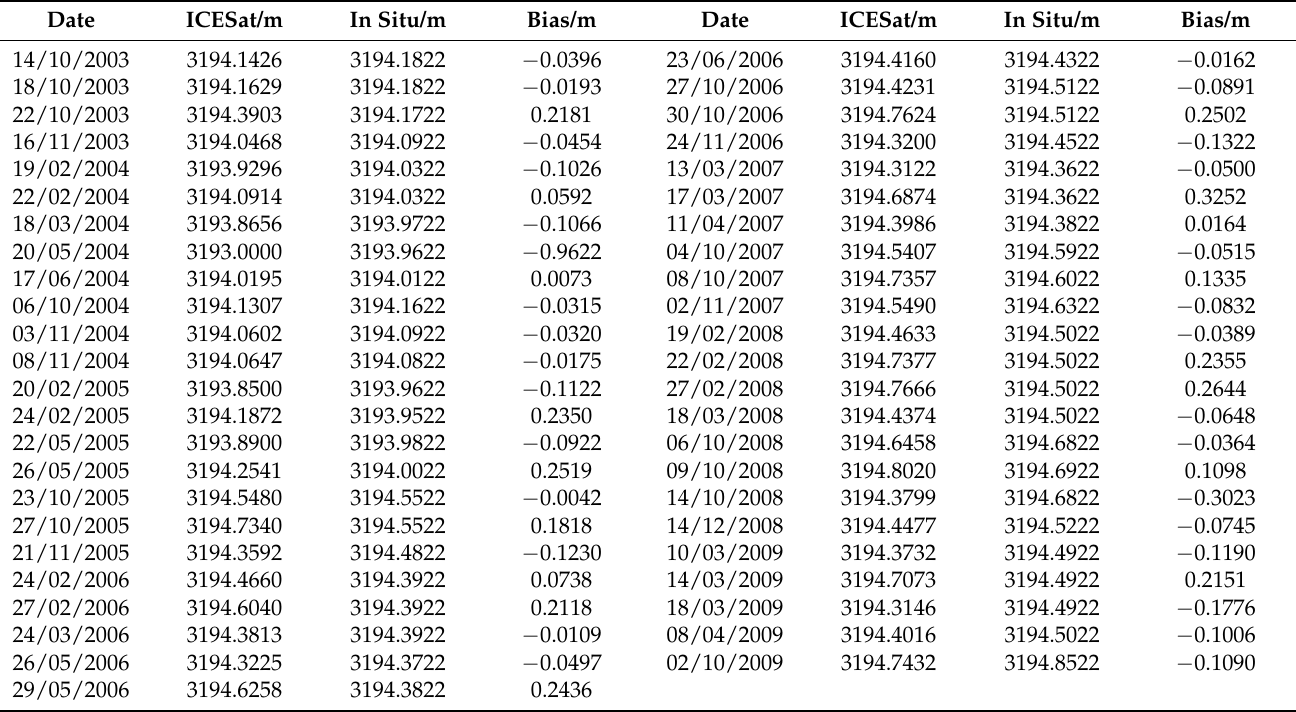
Table A2. The validation for ICESat, using the in situ station data (the underlined point is excluded from further assessment).